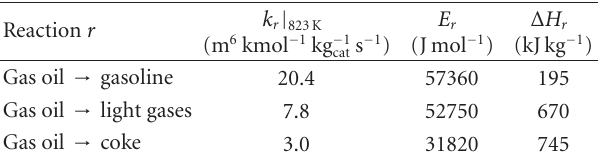
Table 3: Kinetic constants, activation energies, and heats of reaction.